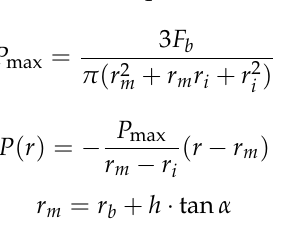
Figure 10. Parameterization of contact interface. However, the pressure distribution on the bolt joint surface is not uniform. The